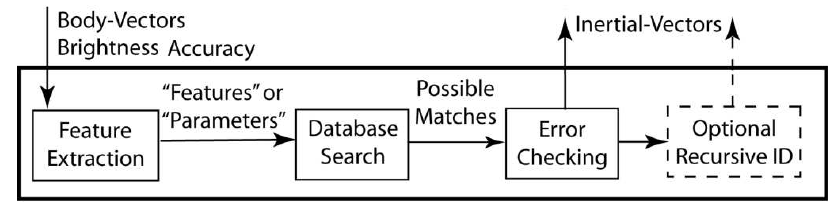
Figure 2. Typical Star-ID